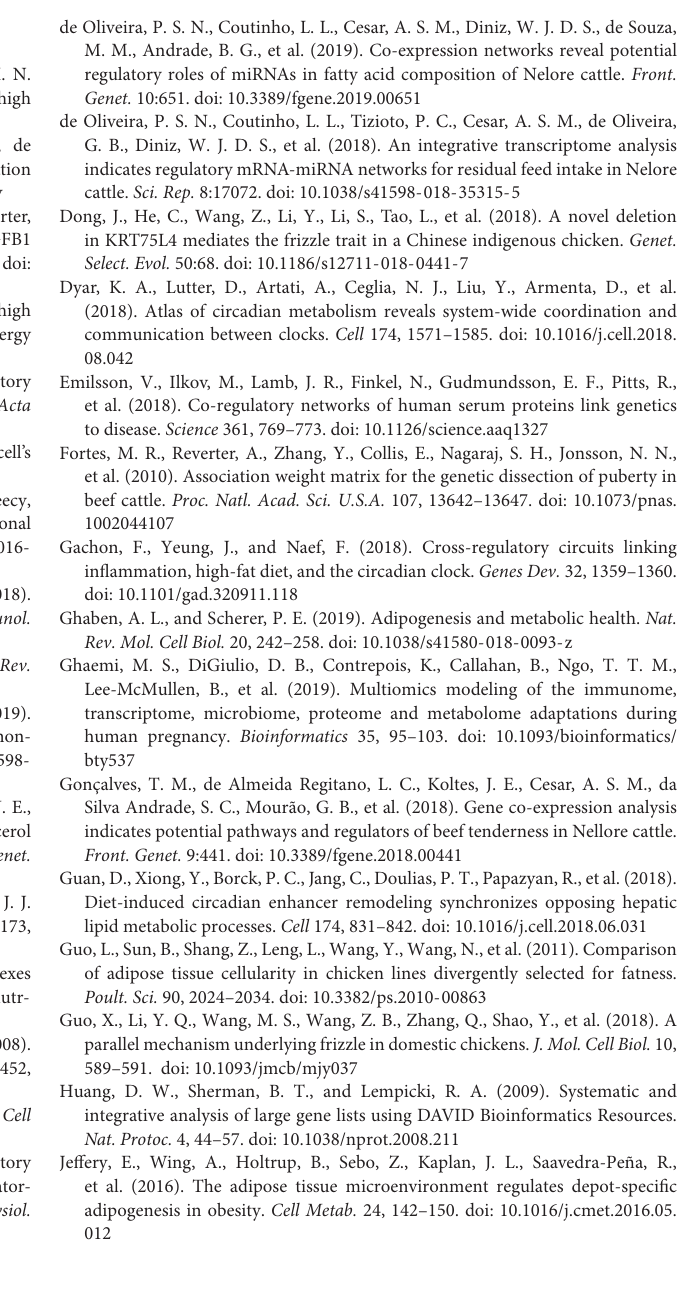
FIGURE S2 | Identification of soft thresholds. The soft thresholds β = 9, 12, 12, 10 for preadipocyte (A) and adipose tissue (B) microarrays of NEAUHLFF, and adipose tissue RNA-seq (C) and microarray (D) of French lines. FIGURE S3 | Gene expression profiles of hub genes in the important modules. Consistent and highly correlated gene expression patterns were identified for hub genes in the network sub-modules, for the four datasets, respectively. FIGURE S4 | Culture and induced differentiation of chicken preadipocyte cell line. Oil red oxygen staining (A) and gene expression trend of differentiation markers of adipocytes in broilers (B) . TABLE S1 | Enrichment analysis of modules. TABLE S2 | Summary of hub genes in modules related to fat